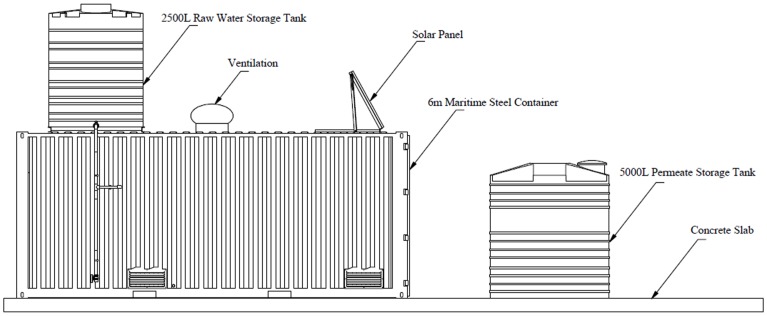
External design of the pilot plant in Tshaanda.